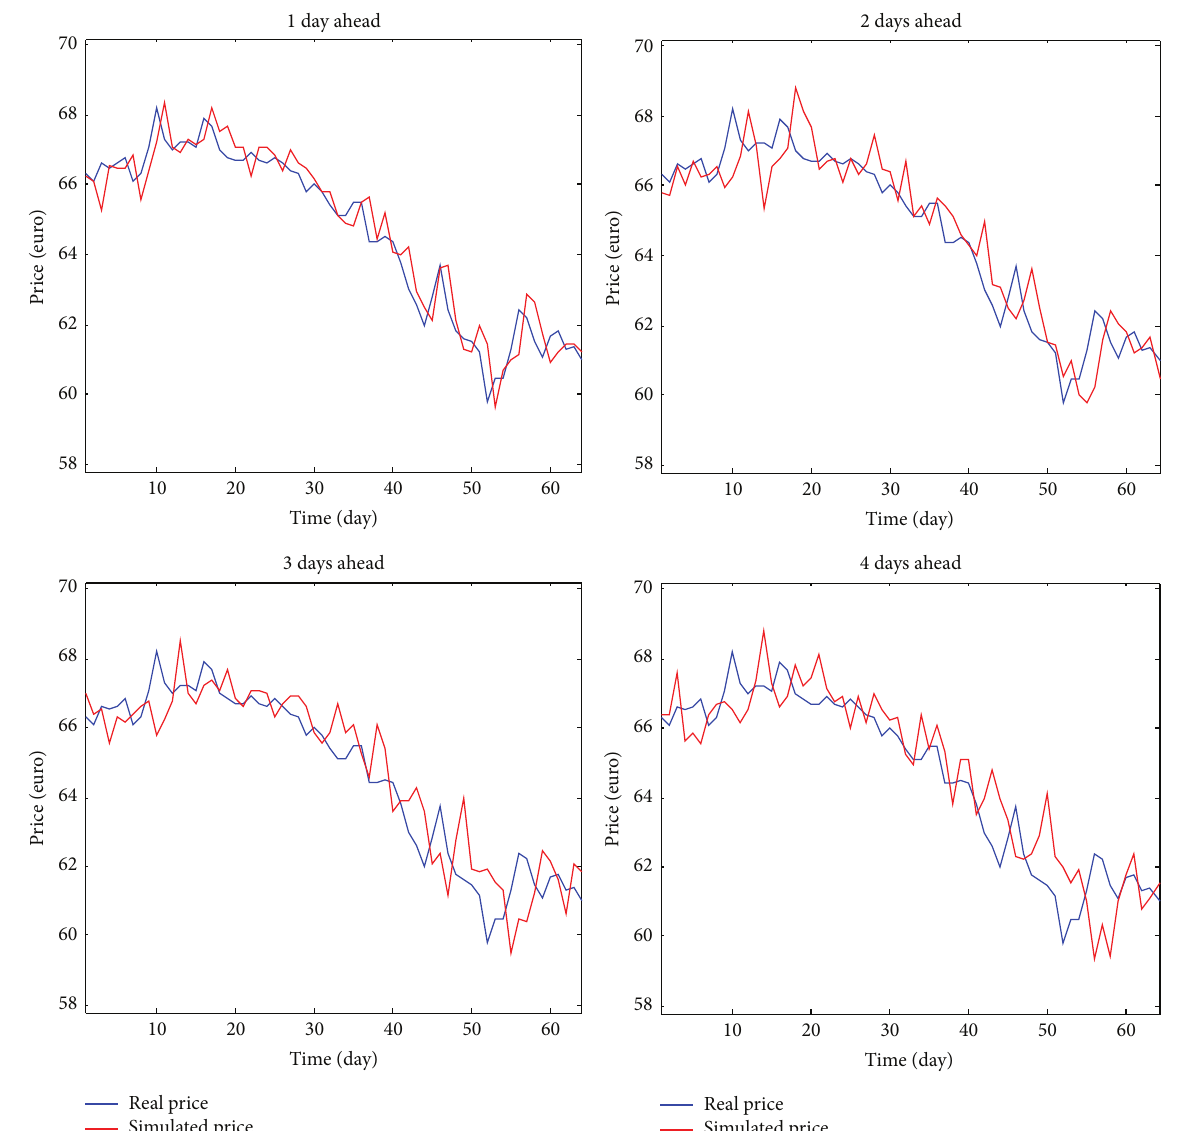
Figure 2: In this figure, we present the price curves obtained by simulating the peak contract of November 2012 using (71) with the specification above stated. The graphics in the figure present forecasts of the contract value at 1, 2, 3 , and 4 days